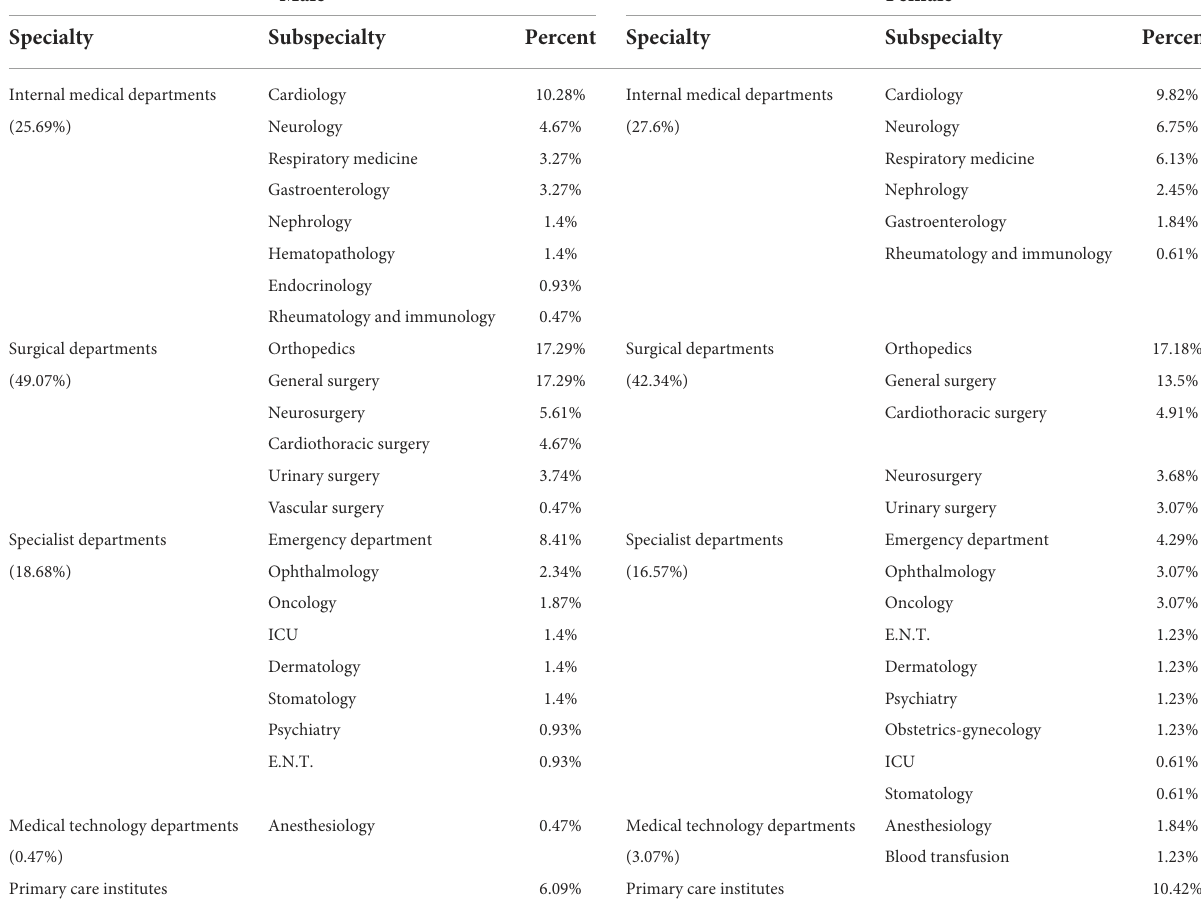
TABLE 1 Proportion of medical errors among older patients in each